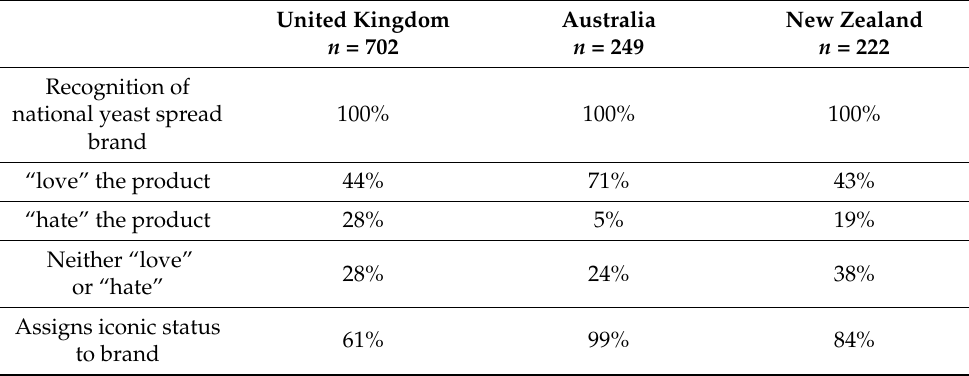
Table 3. Recognition and “iconic” status of national yeast spread